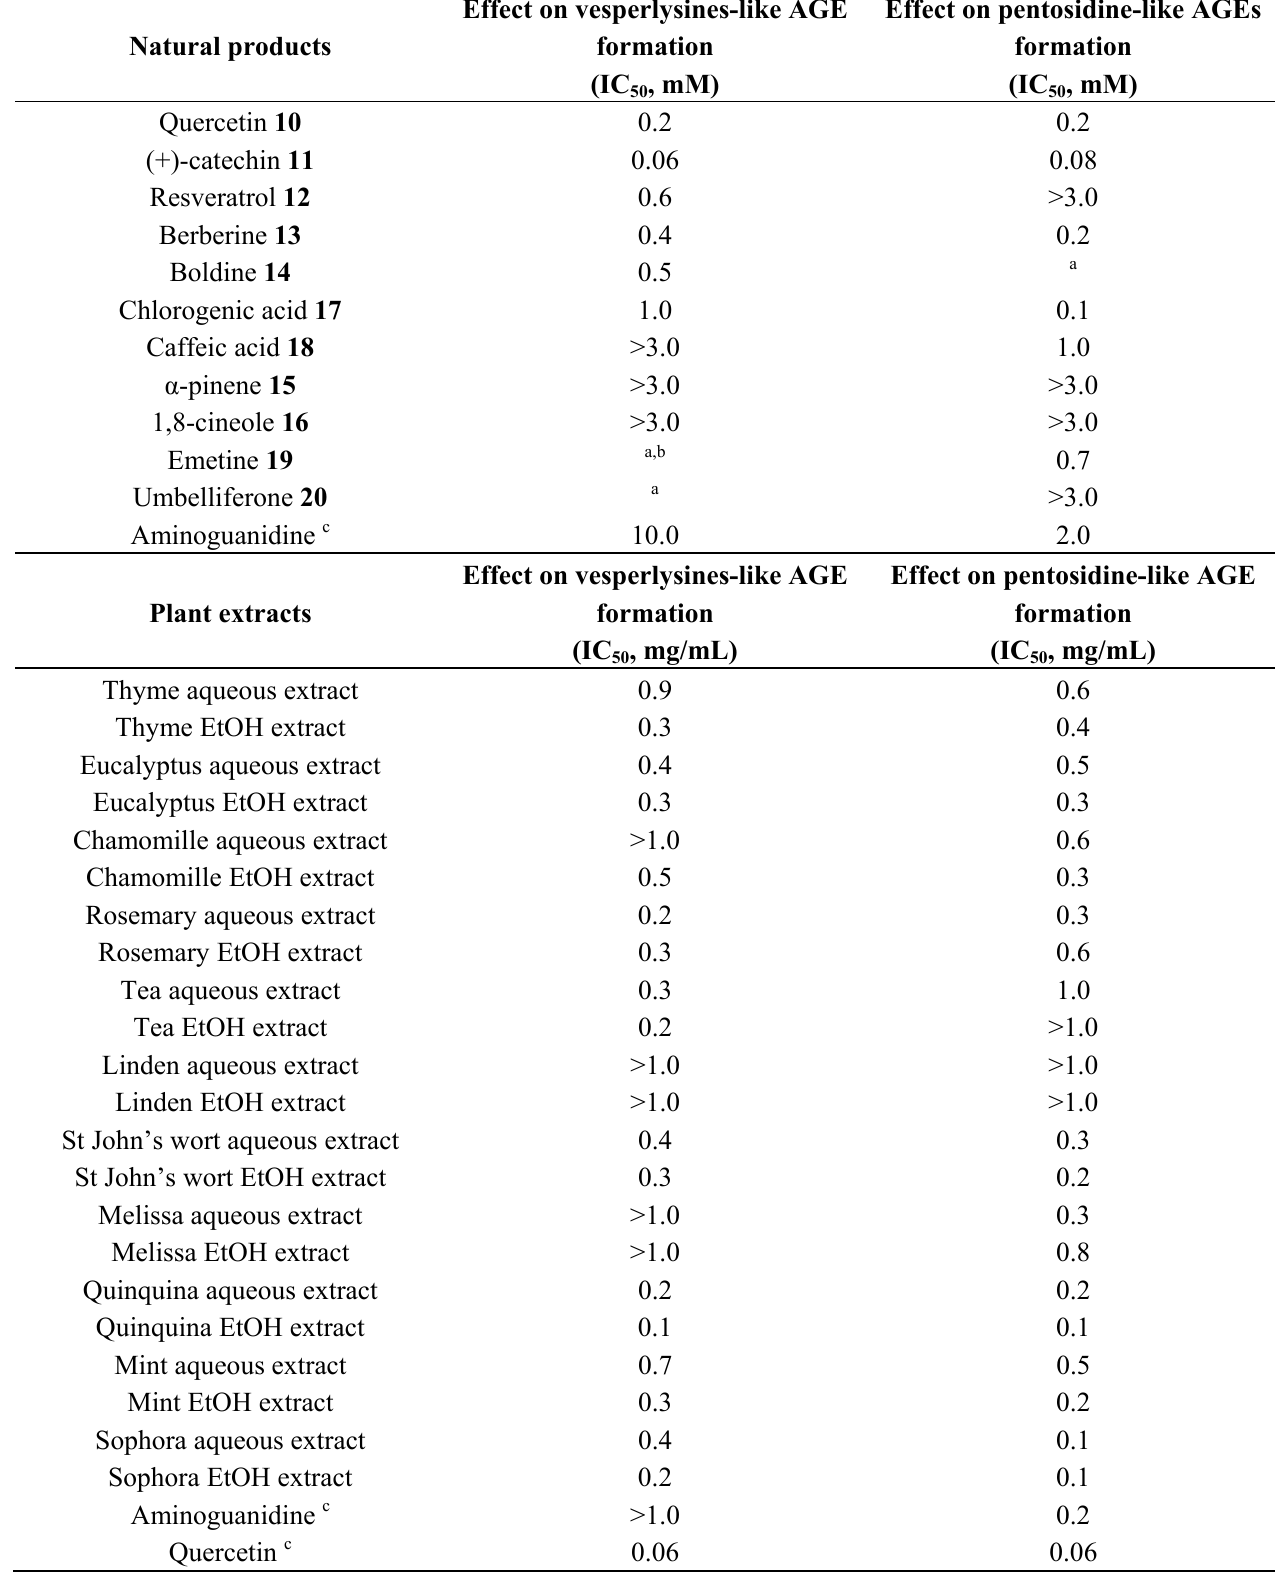
Table 2. Effect of selected NPs and vegetal extracts on vesperlysines- and pentosidine-like calculated from the corresponding sigmoidal dose-response AGE formation expressed as IC 50 curve